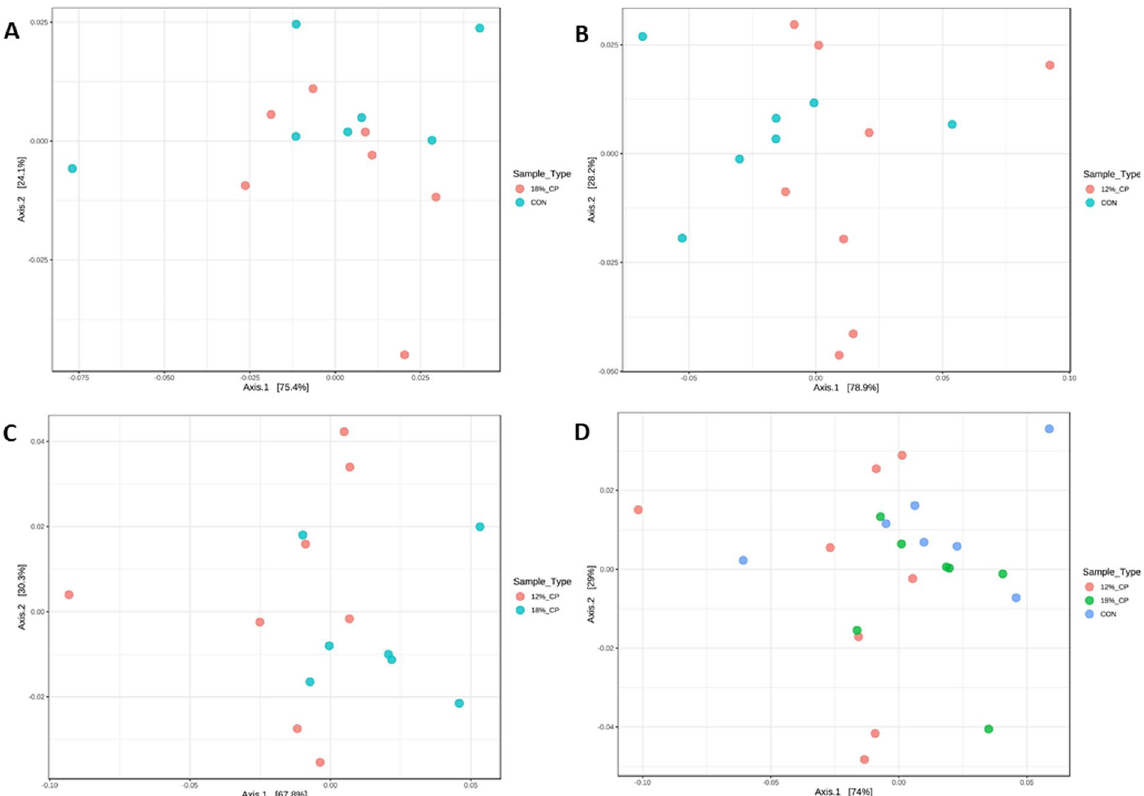
Figure 3. Beta diversity of the fecal bacterial community in nursery pigs fed with different levels of dietary protein at genus level. Principle coordinates analysis (PCoA) of fecal microbiota for ( A ) CON vs. 18% crude protein (CP), ( B ) CON vs. 12% CP, ( C ) 12% CP vs. 18% CP, ( D ) 12% CP vs. 18% CP vs. CON. Pigs are grouped based on their dietary treatments, i.e . CON, control diet with 24% CP; 18% CP, low protein diet with 18% CP; 12% CP, low protein diet with 12% CP. Each node represents an individual pig. Differences were considered significant at P < 0.05. The PERMANOVA P values for CON vs. 18% CP, CON vs. 12% CP, 12% CP vs. 18% CP and 12% CP vs. 18% CP vs. CON were 0.38, 0.07, 0.02 and 0.04, respectively. n = 7, n = 7, n = 8 for CON, 18% CP and 12% CP groups,